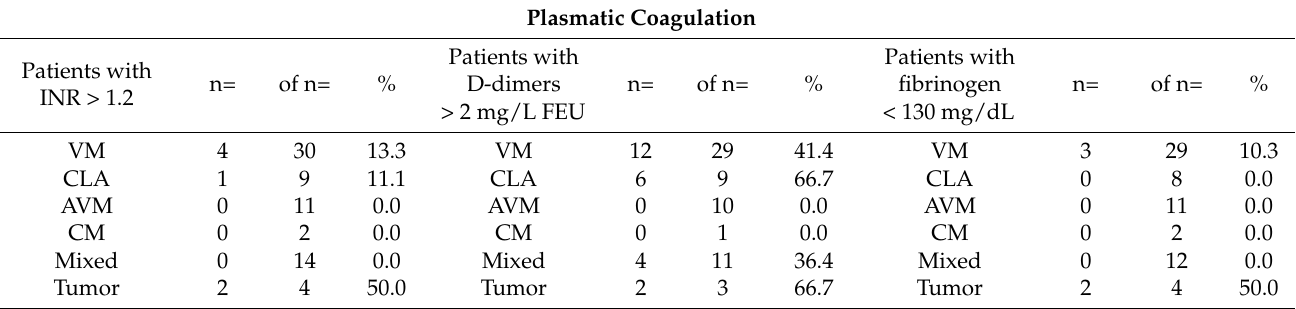
Table 2. Alterations in parameters of plasmatic coagulation specified by disease. Additionally,